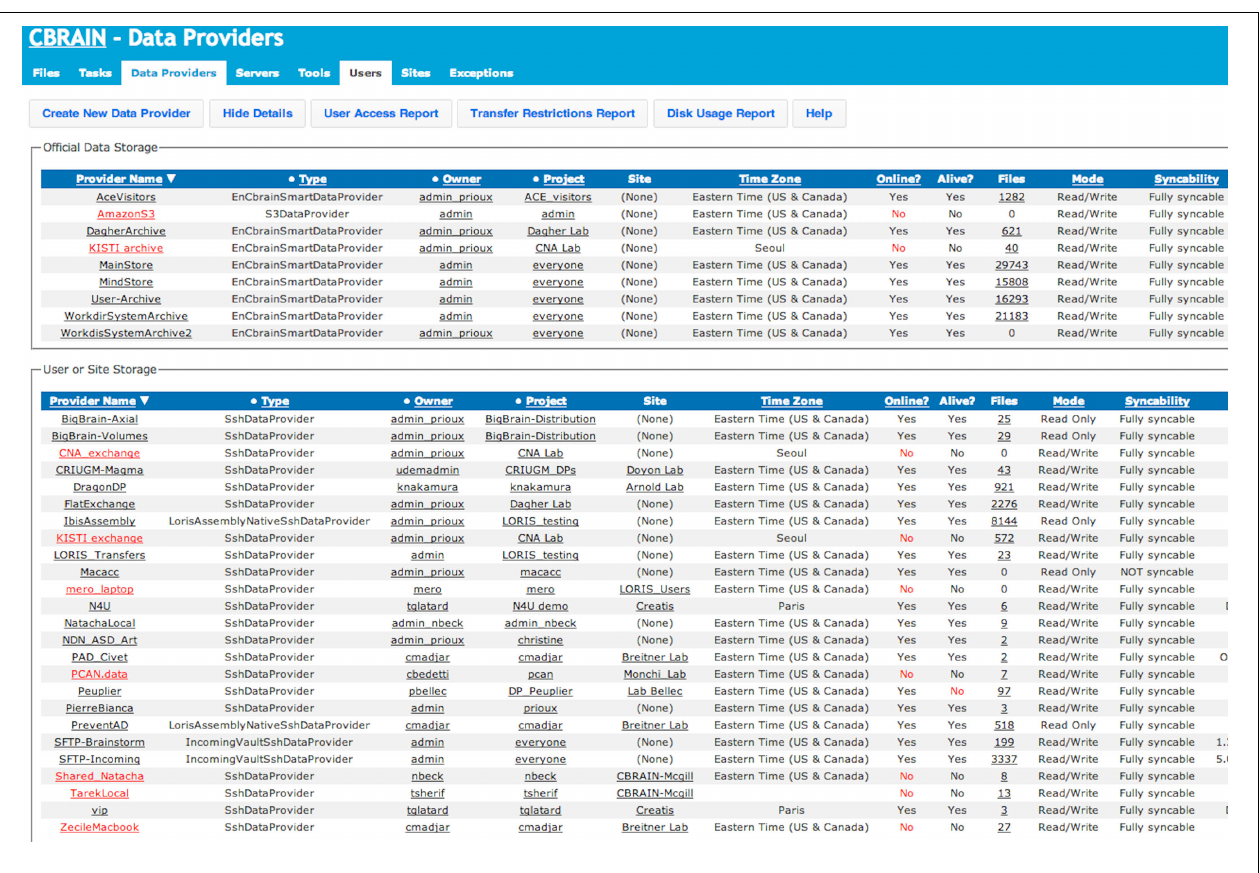
FIGURE 6 | CBRAIN portal: data providers view. This view, presented from an administrative account, shows both the real-time status of official CBRAIN data storages (top) and user created storage (bottom). Main information